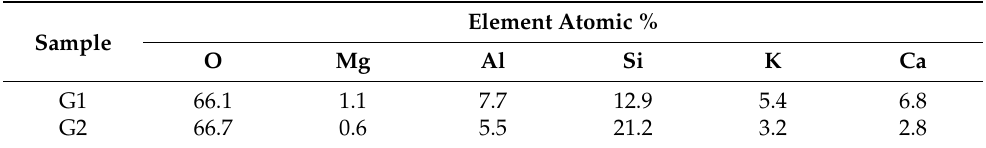
Figure 5. ESEM images of the G1 ( a ) and G2 ( b ) matrices. Table 6. Atomic composition of the G1 and G2 matrices (the data were obtained by EDX determina- tions and represent the average of five measurements in different samples’